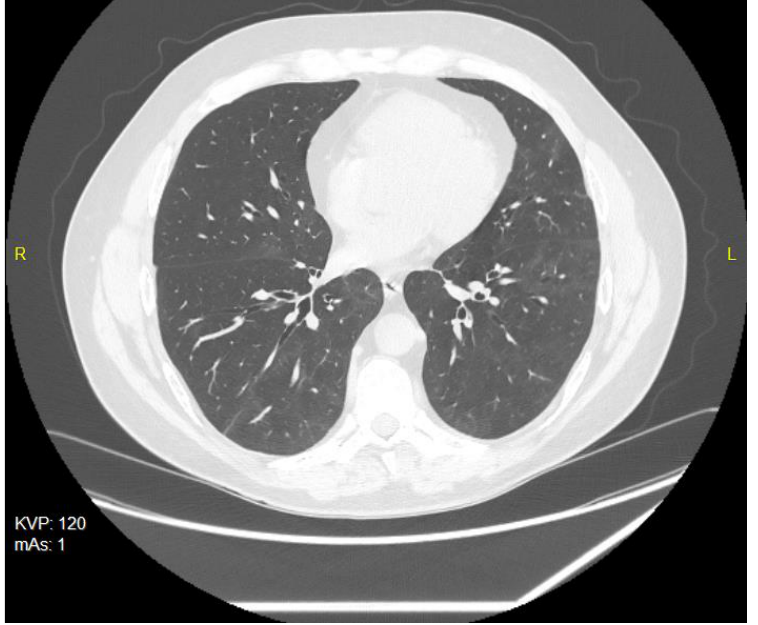
Figure 1. CT scan of the chest of 20 February 2021 — small, bilateral infiltrates of the grain-glass opacity type. opacity type. Table 1. Events recorded during the whole study period. Table 1. Events recorded during the whole study